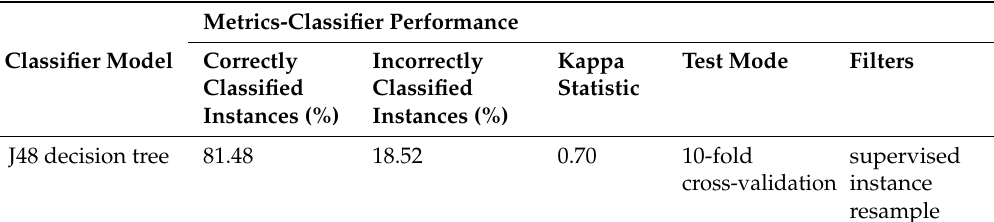
Table 4. Classifier performance for scale class prediction models of the level of the environmental e ffi ciency of biofuel with the resample